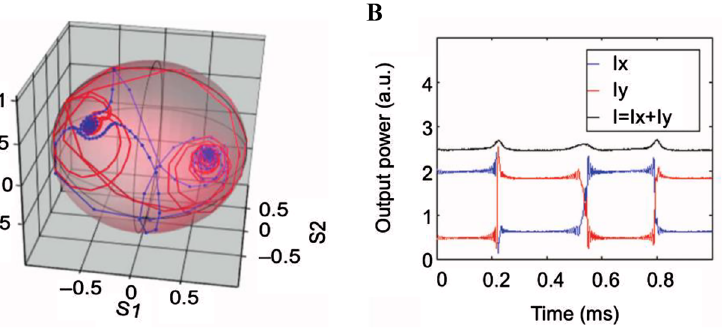
Figure 10: Typical fixed point and limited cycle shown in Poincare sphere. (A) Fixed point. (B) Limited cycle.